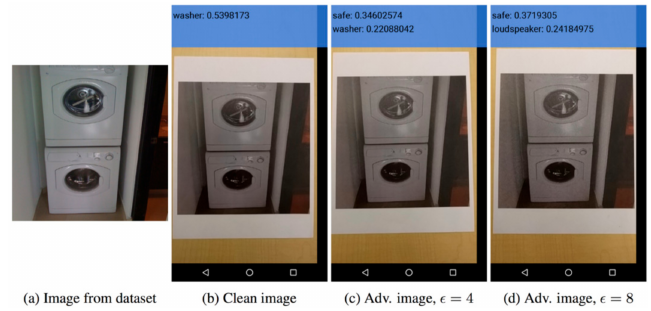
Figure 2. Adversarial attacks on printed out images